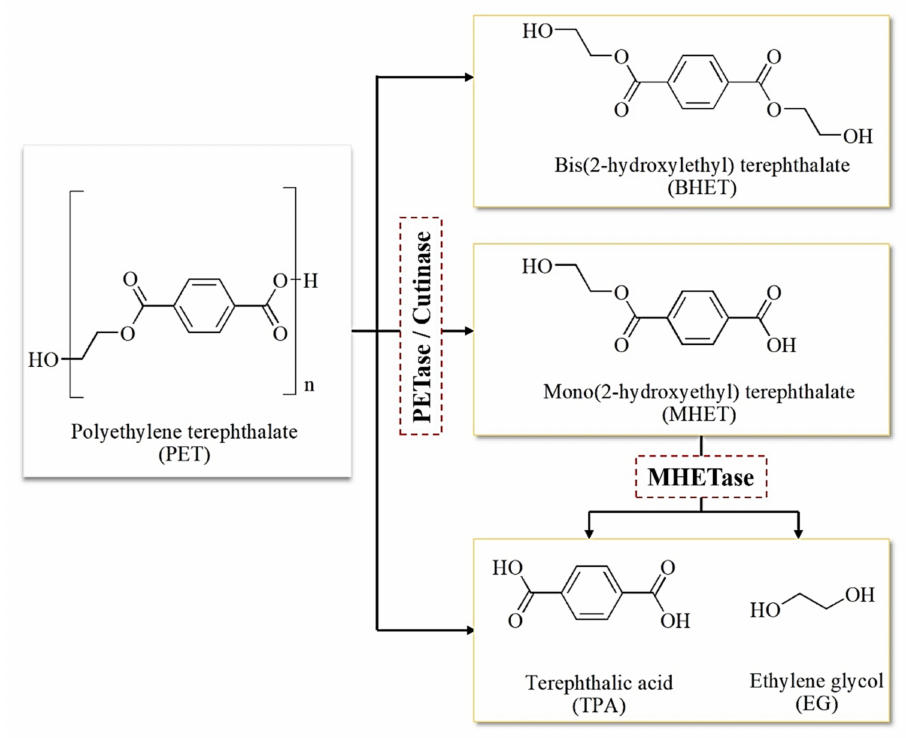
Figure 3. Schematic depiction of PET degradation catalyzed by PETase or cutinase. Polyethylene terephthalate (PET) is hydrolyzed by PETase/cutinase to produce bis(2-hydroxyethyl) terephthalate (BHET), mono(2-hydroxyethyl) terephthalate (MHET), terephthalic acid (TPA), and ethylene glycol (EG). MHET is hydrolyzed again by the second enzyme, MHETase, to yield terephthalic acid (TPA) and ethylene glycol